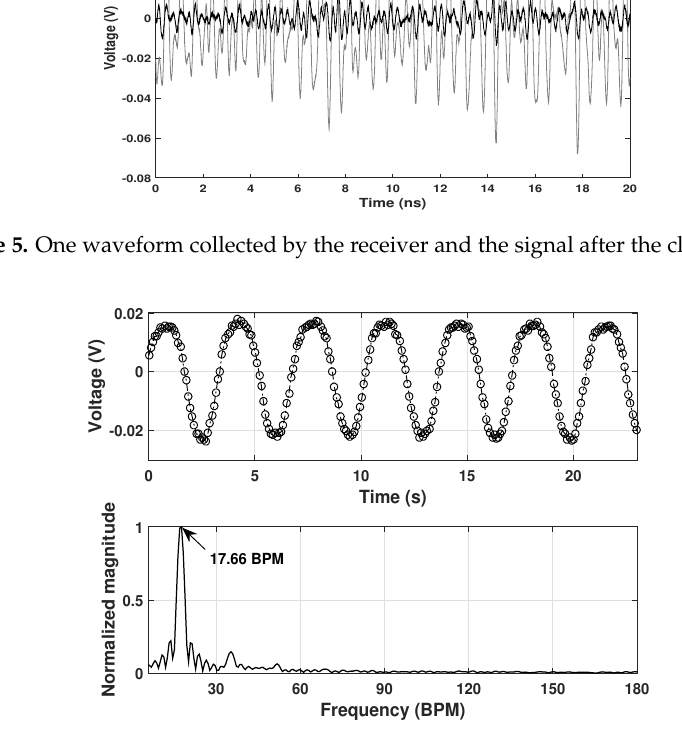
Figure 6. Detection results of the robot movement. The top figure shows a slow time signal and the bottom figure is its frequency